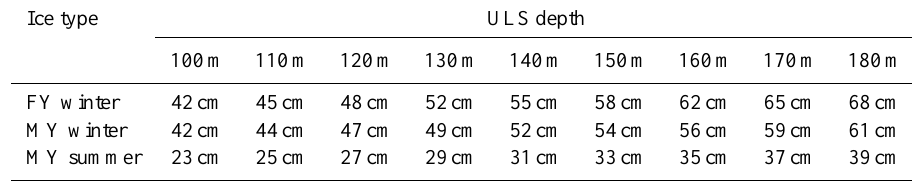
Table 4. ULS biases calculated after Rothrock and Wensnahan (2007) for di ff erent ULS depths. Ice type ULS